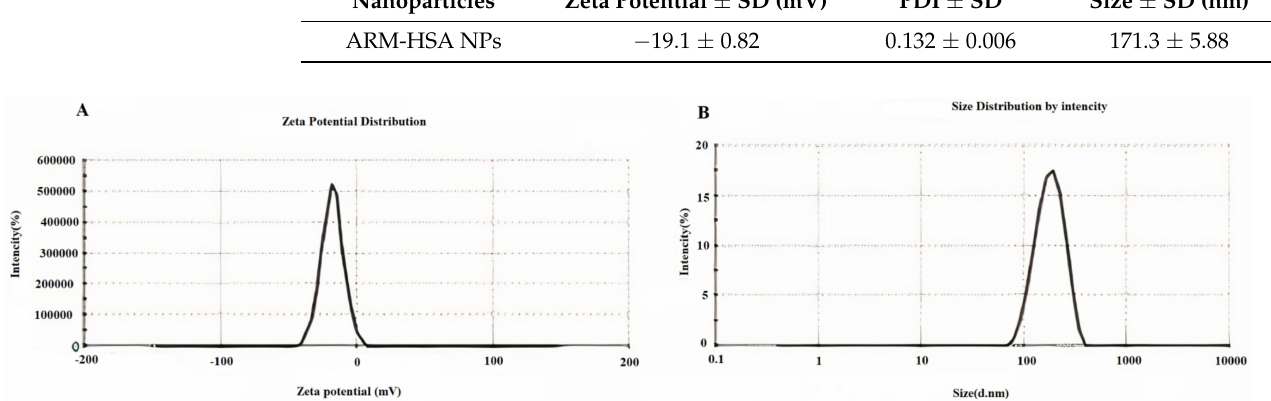
Figure 2. Zeta potential ( A ) and Dynamic light scattering ( B ) of albumin–artemether nanoparticles show the surface charge and particle